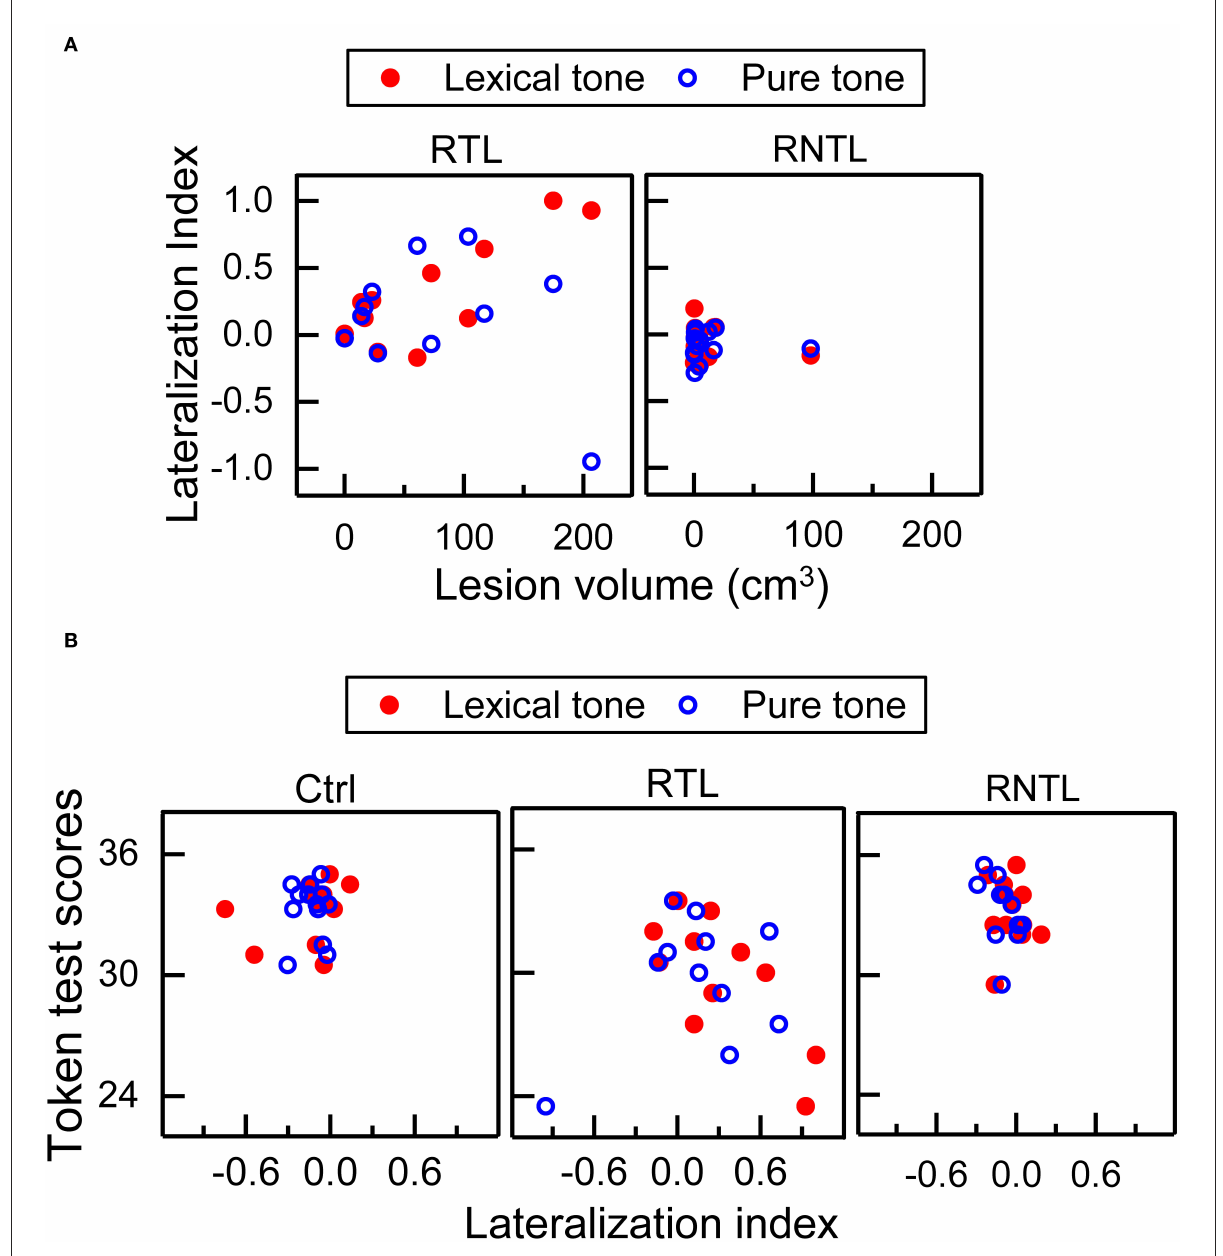
FIGURE4 Correlations between lesion volume and lateralization index (LI), and those between LI and Token test scores. (A) Significant correlation between lesion volume and LI was only found in the RTL group for the lexical-tone contrast—more lesion volume corresponding to less right hemisphere involvement. (B) Significant correlation between LI and Token test scores was only found in the RTL group for the lexical-tone contrast—less right hemisphere involvement corresponding to worse speech comprehension ability of Mandarin